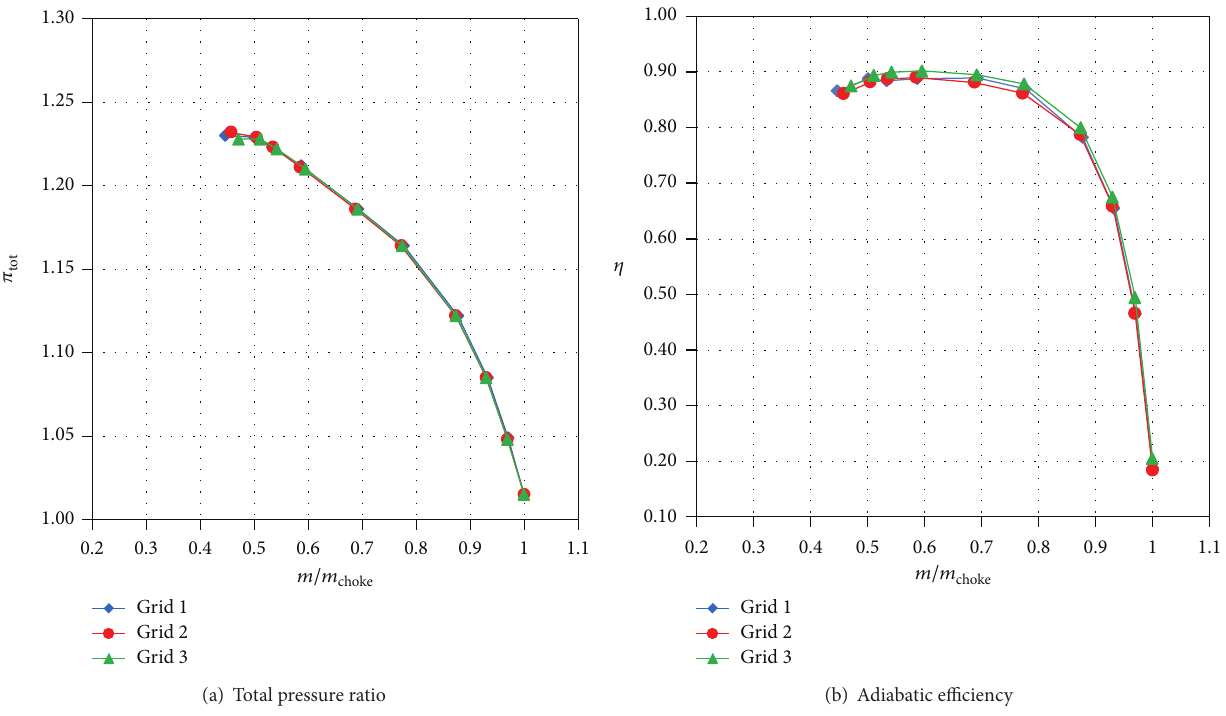
Figure 10: Simulation results with three grid